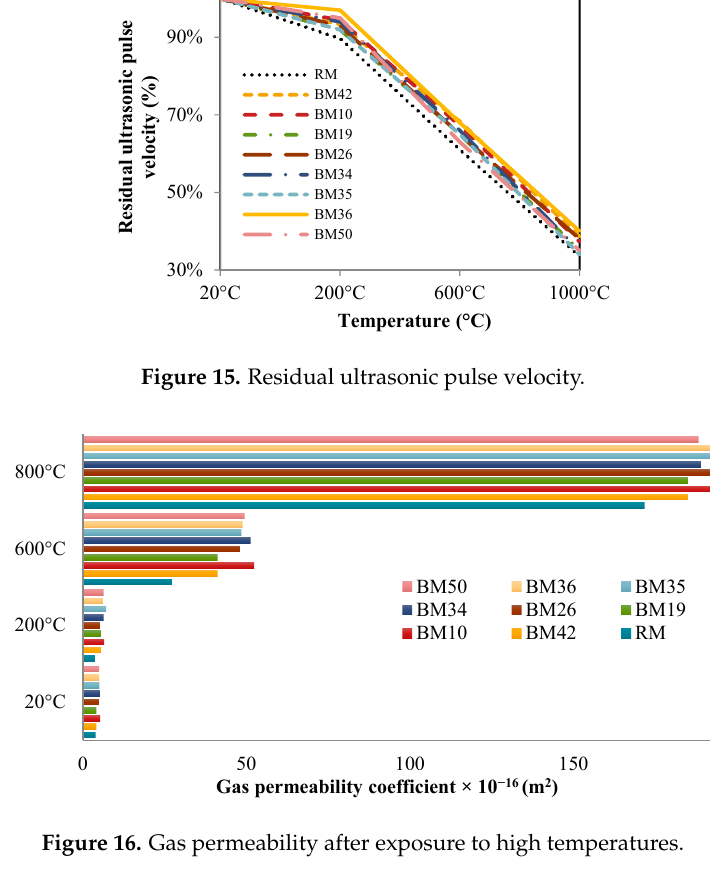
Figure 16. Gas permeability after exposure to high temperatures.